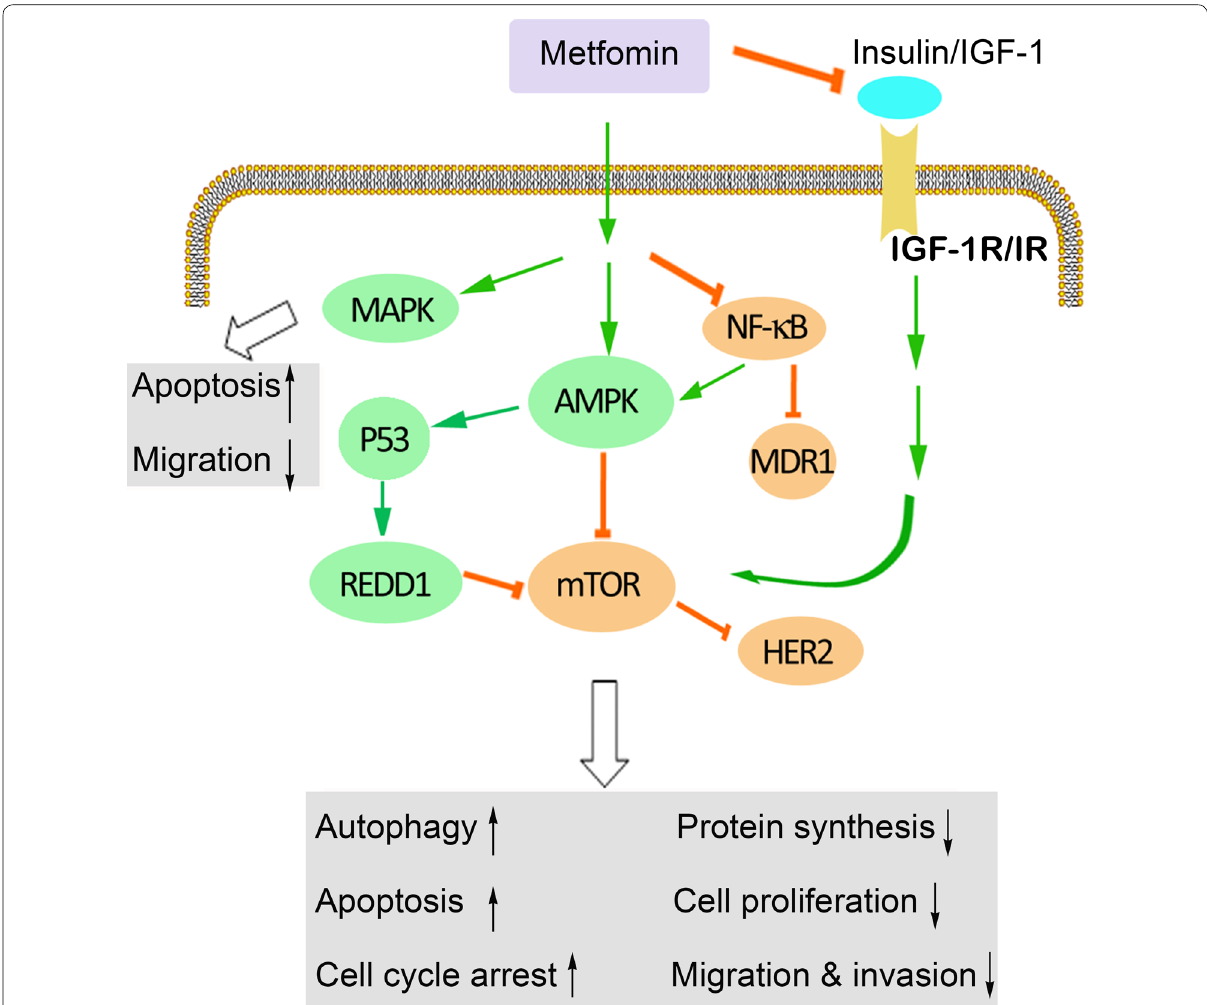
Fig. 1 Signaling pathways through which metformin acts in cancer. IGF ‑ 1 insulin‑like growth factor‑1, MAPK mitogen‑activated protein kinase, REDD1 regulated in development and DNA damage 1, AMPK adenosine monophosphate‑activated protein kinase, mTOR mammalian target of rapamycin, NF ‑ κB nuclear factor kappaB, MDR1 multidrug resistance 1, HER2 human epidermal growth factor receptor‑2, IGF ‑ 1R IGF‑1 receptor, IR insulin